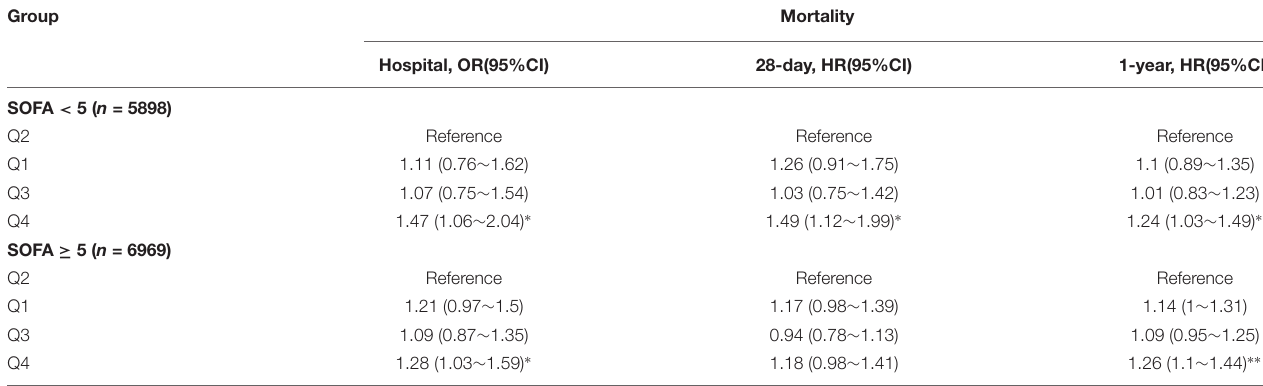
TABLE 4 | OR/HR With 95% CIs for mortality associated with MAP ARV in patients with different SOFA scores.